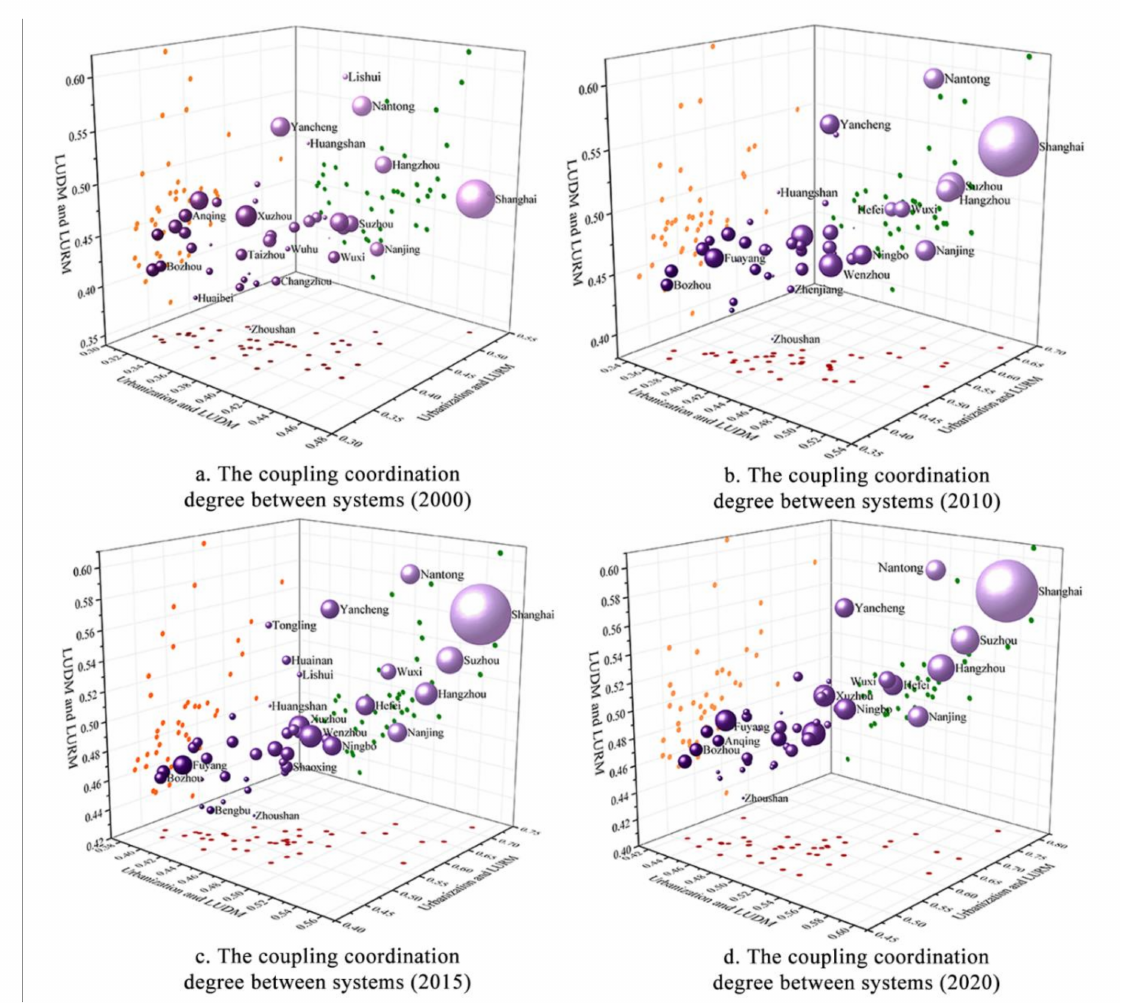
Figure 5. Time evolution of the coupling coordination relationship between urbanization and land-use morphology in the Yangtze River